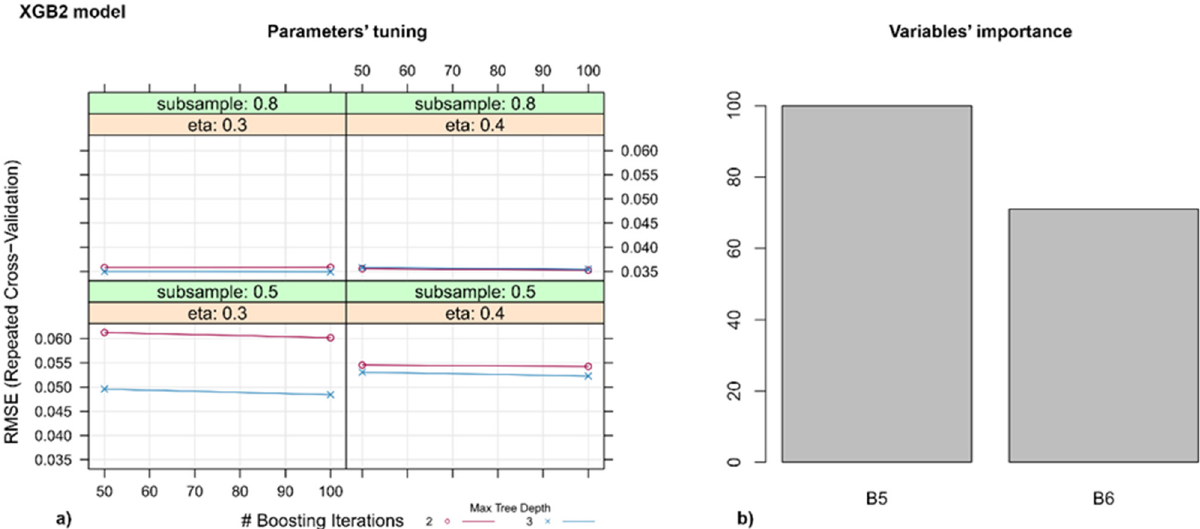
Figure 8. XGB2 model parameters tuning showing the optimal setting: 50 boosting iterations, subsample = 0.8, eta = 0.3, and maximum tree depth = 3 ( a ). Variables’ importance for XGB2: B5 (R408.85 nm) and B6 (R411.74 nm) ( b ).